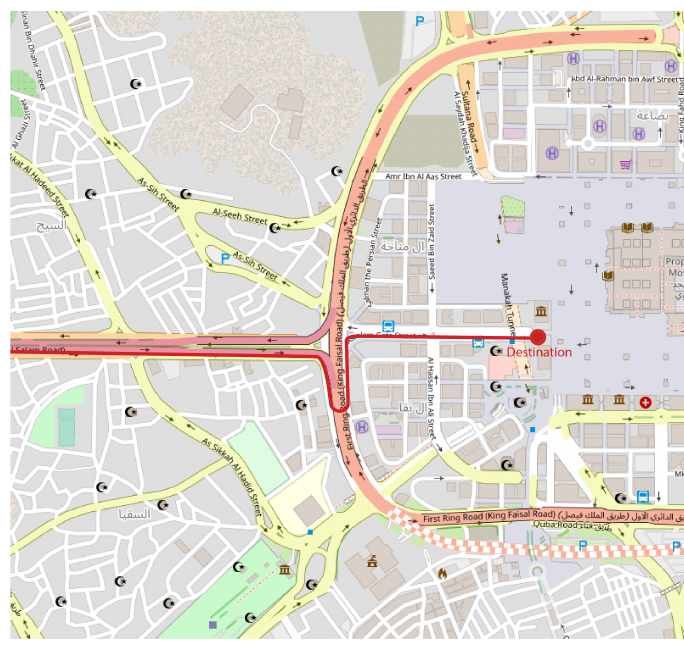
Figure 6. Route 1—West Highway to Prophet’s Mosque.